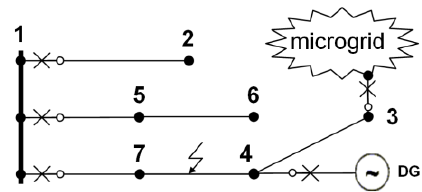
Figure 1. A distribution smart grid with a distributed generator and a